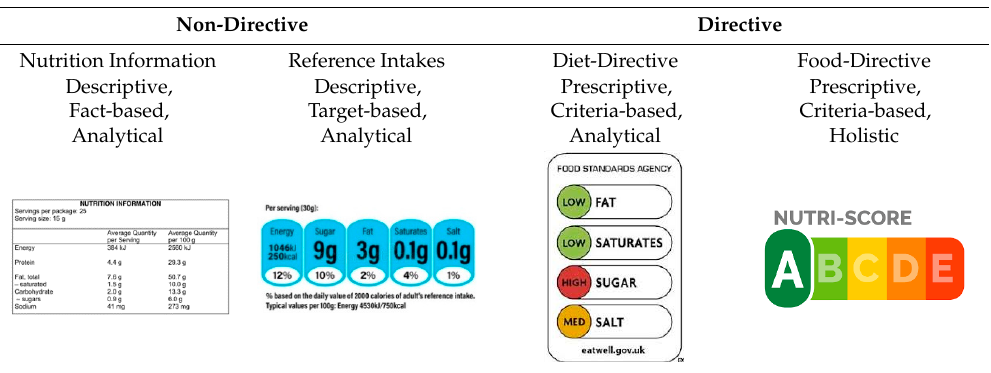
From left to right: Nutritional Information Panel, Reference Intakes Label, Multiple Traffic Lights (simplified version without Nutritional Information and Reference Intakes) and Nutri-Score.